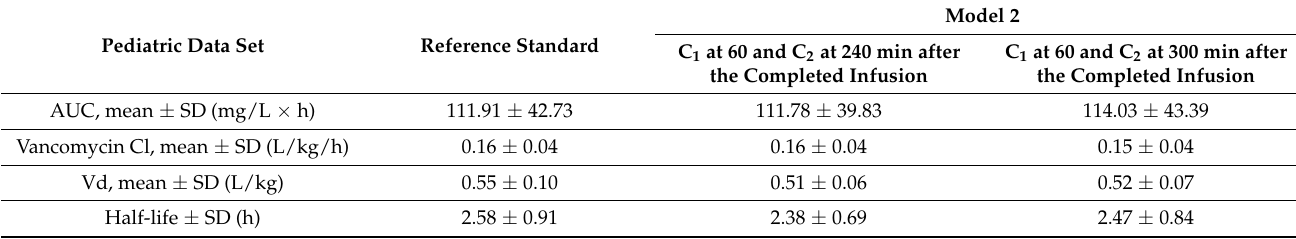
Table 3. Summary of pharmacokinetic parameters of the pediatric data set derived from selected equation-paired concentration time point combinations compared to the reference